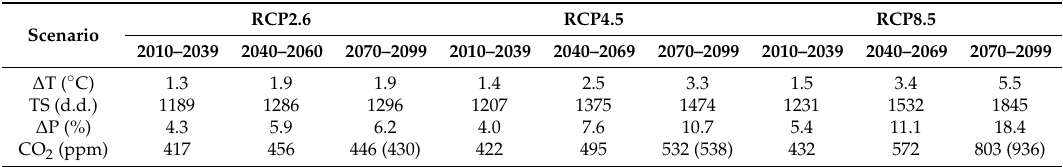
Table 3. Average changes in temperature ( ∆ T, ◦ C), precipitation ( ∆ P, %), average temperature sum (TS, d.d.) and atmospheric CO 2 (ppm) level under minor (RCP2.6), moderate (RCP4.5),